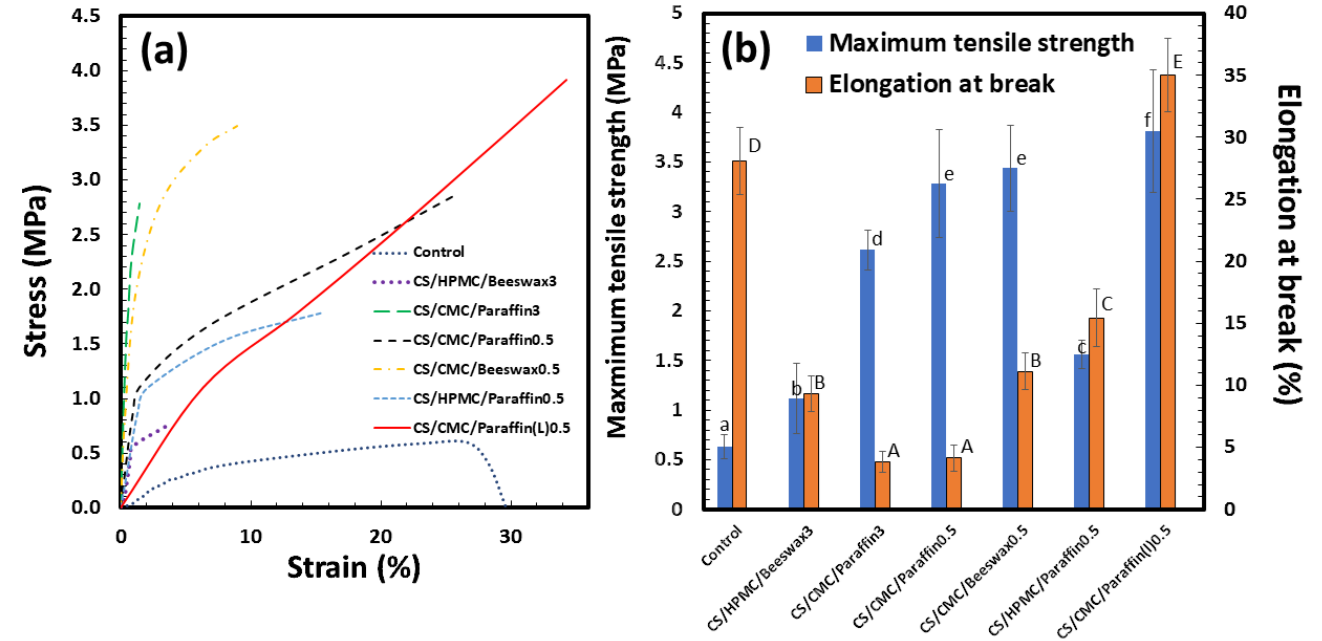
Figure 1. Tensile properties of coating materials: ( a ) Stress–strain curve and ( b ) maximum tensile strength and elongation at break ( n = 5). The control indicates the starch/glycerol blend. Means with different lowercase letters of elongation at break and the uppercase letters of maximum tensile strength were significantly different ( p < 0.05).